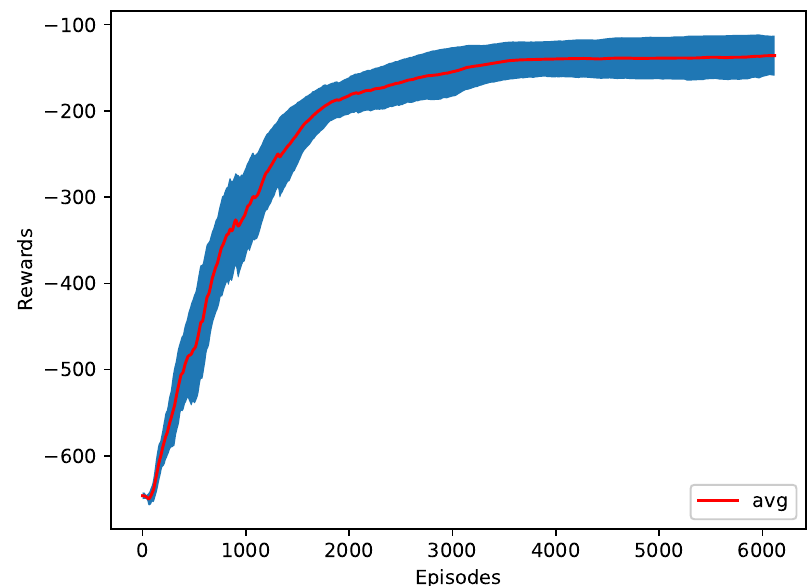
Figure 14. The training plot of the multi-objective reward function (Case 1).